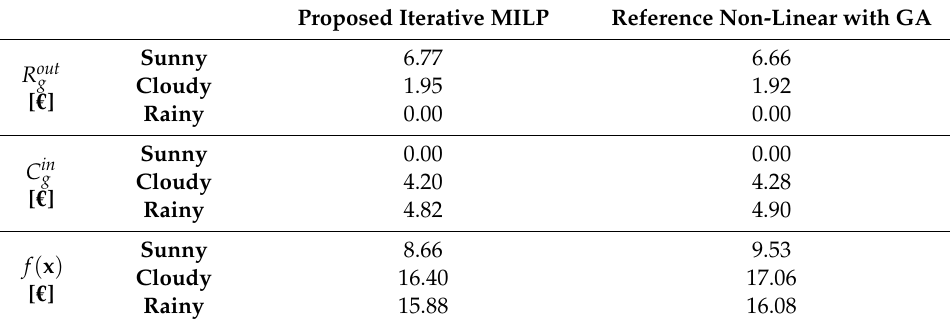
Table 4. Techno-economic performances of the microgrid for the three typical days. Proposed Iterative